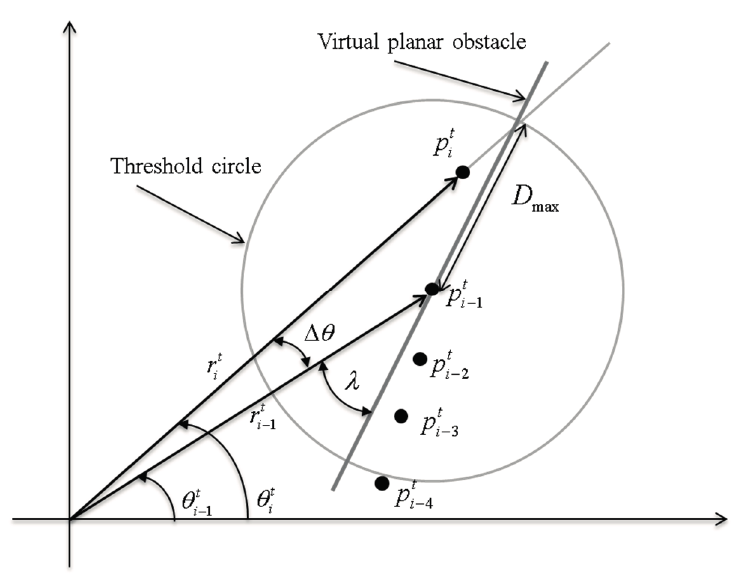
Figure 3. Adaptive Breakpoint Detector (ABD).